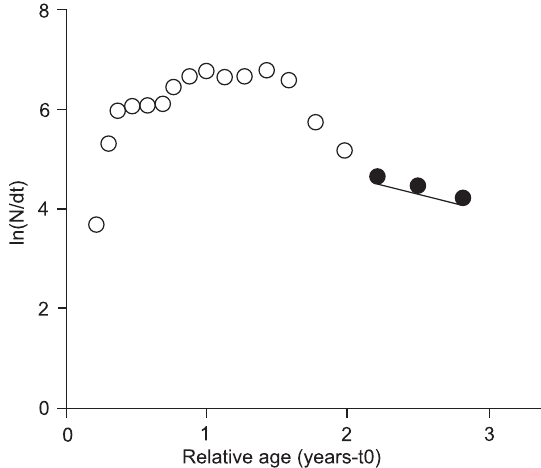
Figure 8. Capture curve converted by the Scolelepis goodbodyi population size. Black circles represent the monthly values used for the calculation of the mortality